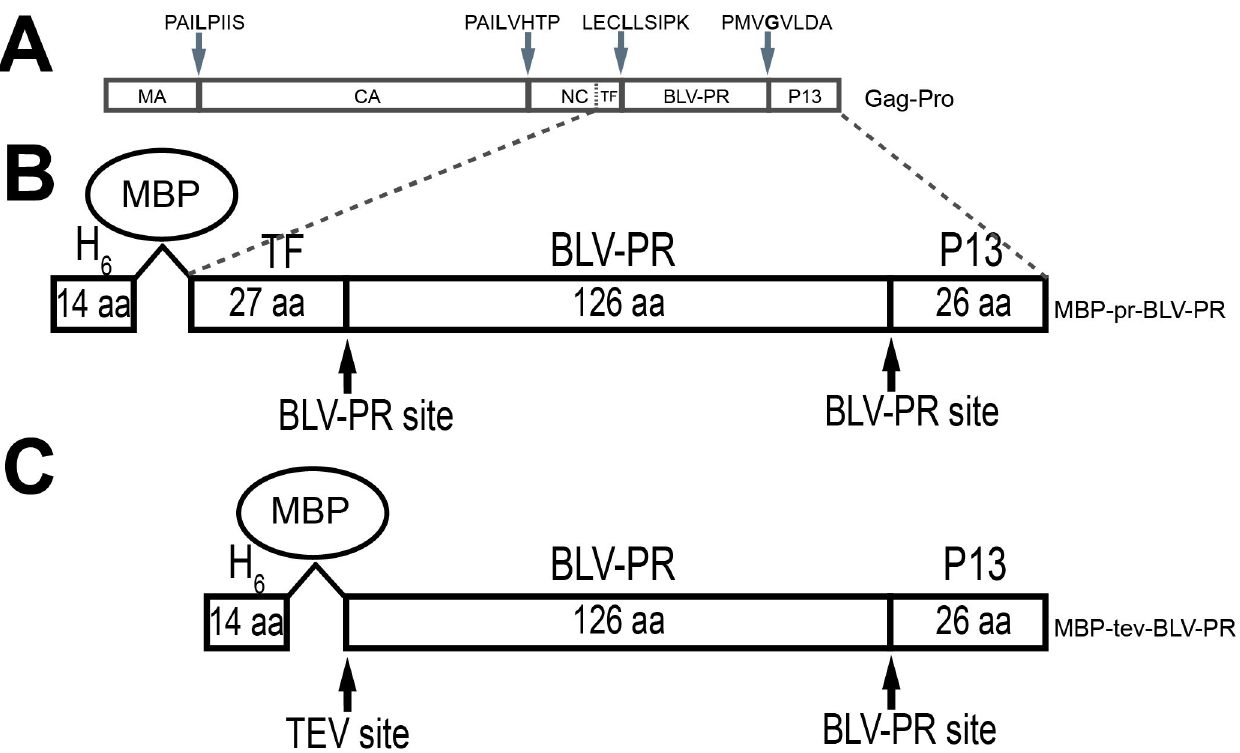
Fig 1. Constructs for expression of BLV-PR. (A) Schematic representation Gag-Pro, a precursor polyprotein of BLV. Gag-Pro is processed by BLV-PR, releasing matrix (MA), capsid (CA) and nucleocapsid (NC) proteins. Immature BLV-PR is fused to the C-terminal end of Gag, separated by a transframe region (TF), and with a peptide extension (P13) at the C-terminus. The hydrolysis sites for BLV-PR are indicated by grey arrows with the amino acid sequence. P1 is leucine for MA-CA, CA-NC and TF-PR while P1 is glycine for PR-P13. A part of the polyprotein is expanded in the panels below. (B) MBP- pr-BLV-PR. This BLV-PR expression construct contains TF and P13 of immature BLV-PR, with the native hydrolysis sites for BLV-PR. The N-terminal end is linked to maltose binding protein (MBP) and has a tandem of six histidines (H 6 ) for affinity purification. (C) MBP-tev-BLV-PR. This construct contains MBP with H 6 , separated from BLV-PR by a hydrolysis site for TEV protease (ENLYFQL, with leucine in P1´). The black arrows show the hydrolysis sites.